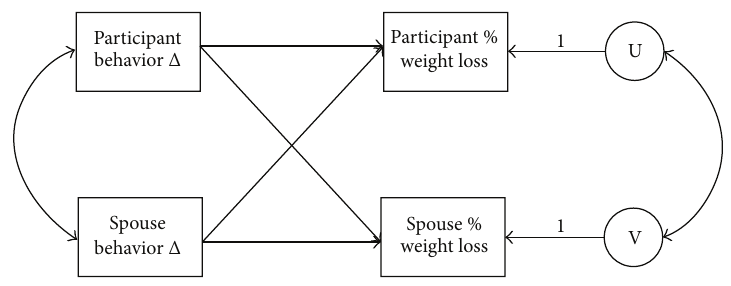
Figure 1: Basic APIM: conceptual model.